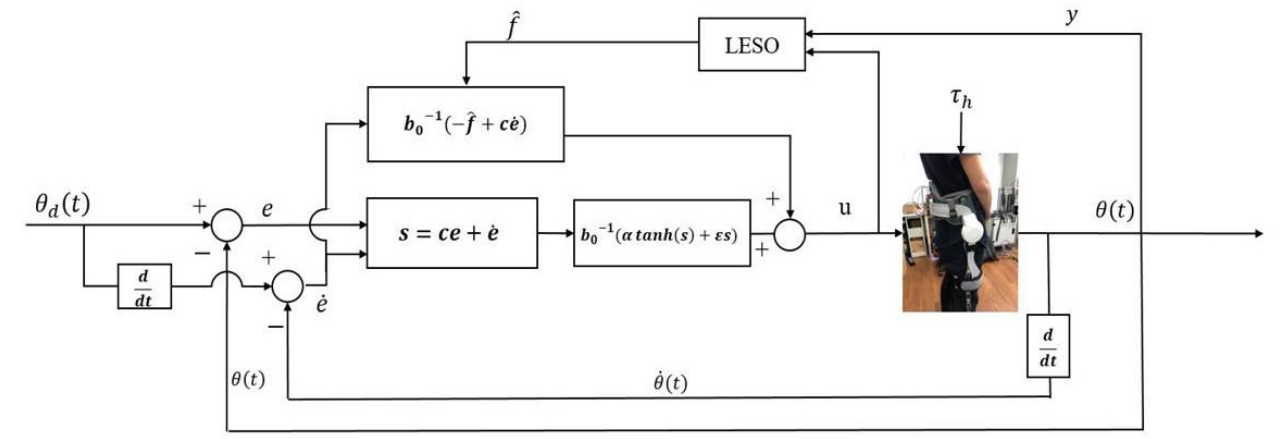
Figure 5. Control structure of LESO-based SMC.